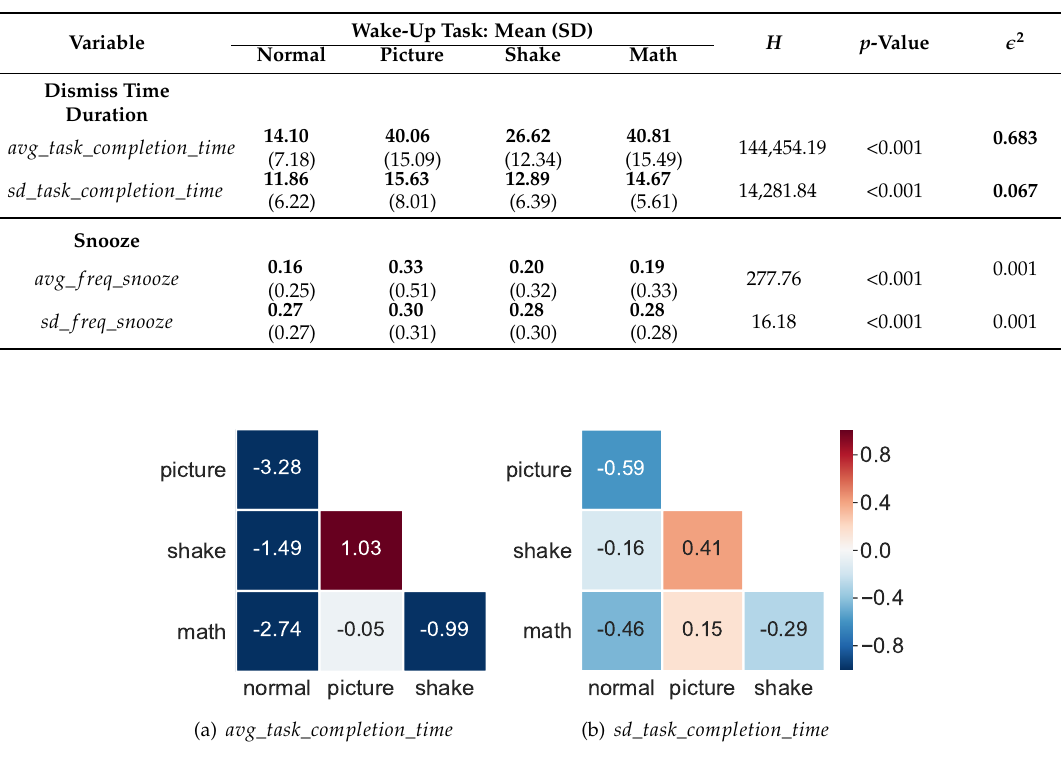
Figure 3. The magnitude of task-wise mean differences on alarm dismiss-usage: Cohen’s d (col,